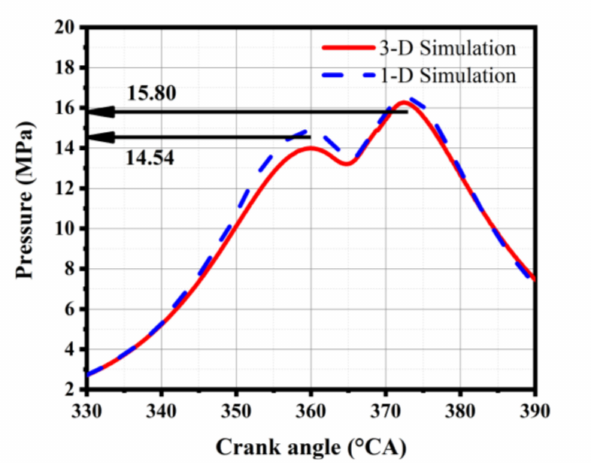
Figure 7. The comparison of pressure in the cylinder of 1D simulation and 3D